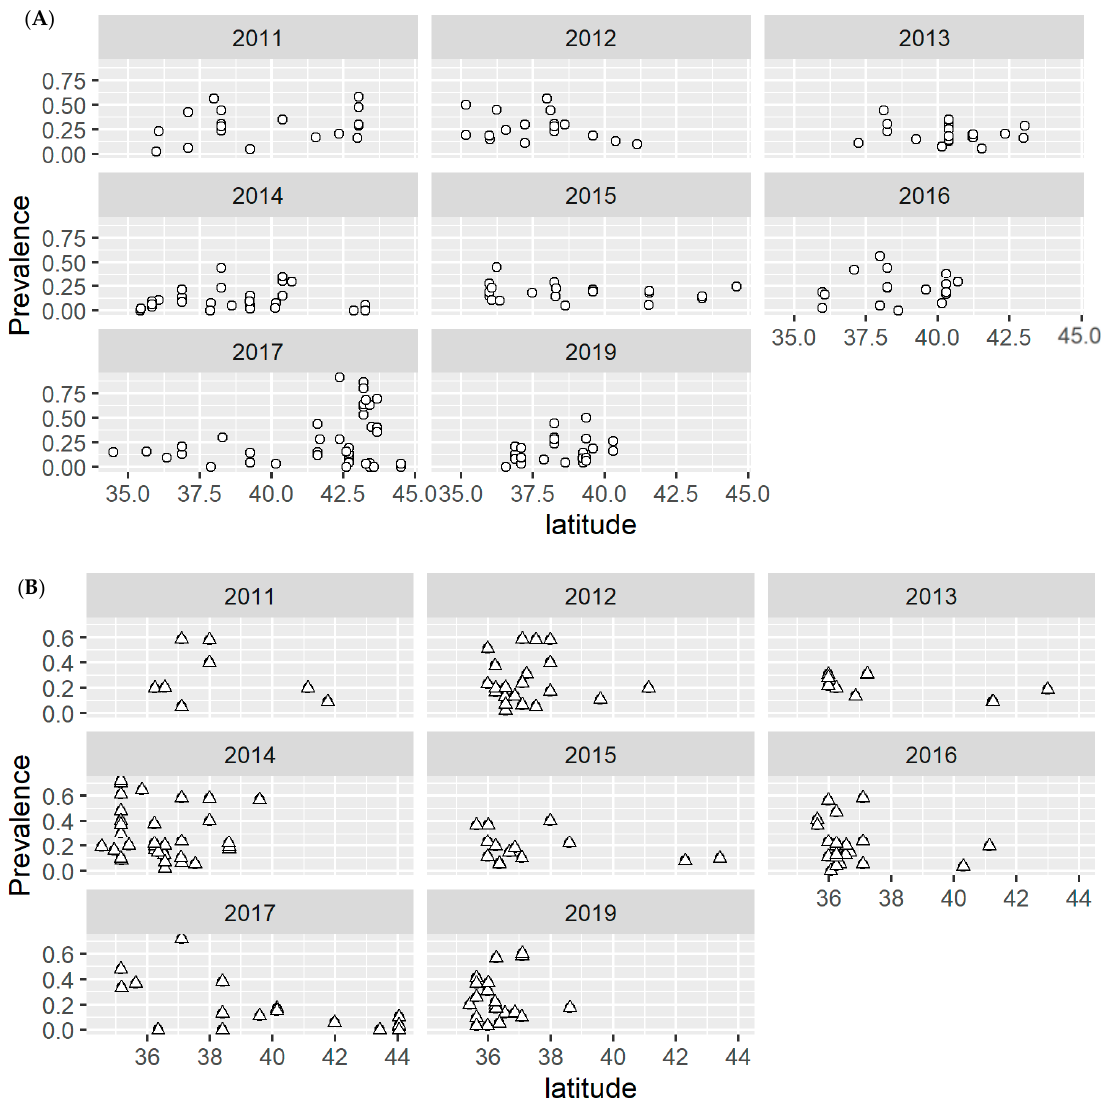
Figure 3. Box plots of weevil infestation prevalence per tree for acorns of both Q. alba and Q. rubra . No significant difference in weevil prevalence was detected for the two tree species (see Results). However, note that the few trees with highest levels of infestation were Q. rubra . There was no significant difference in prevalence between northern and southern trees for Q. rubra (W = 4617, p -value = 0.9049, Figure 4A). However, in Q. alba , prevalence was significantly higher (W = 640, p -value = 0.00006, Figure 4B) in southern trees (mean